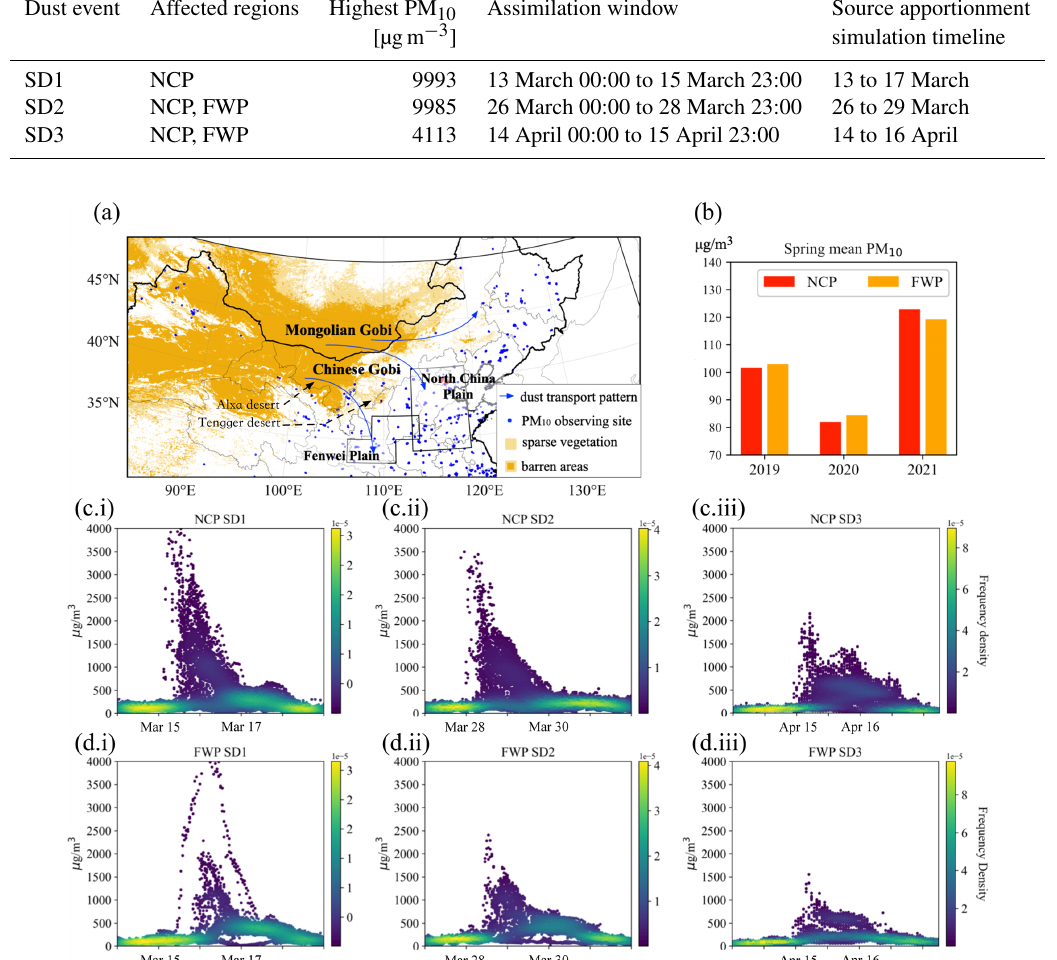
Table 1. Descriptions of the three severe dust storm events that occurred in China in spring 2021. Time zone is China Standard Time (CST). Dust event